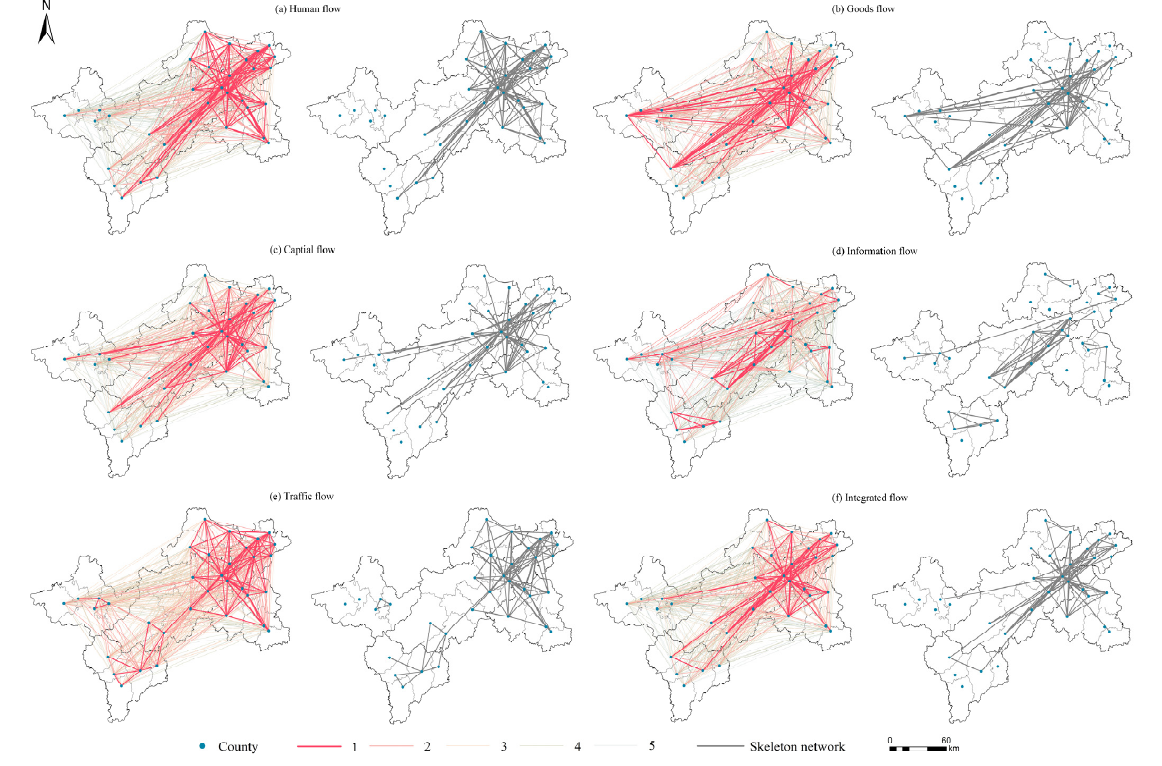
Figure 6. The hierarchical distribution diagram of network connections. Table 2. QAP correlation analysis of multi-dimensional